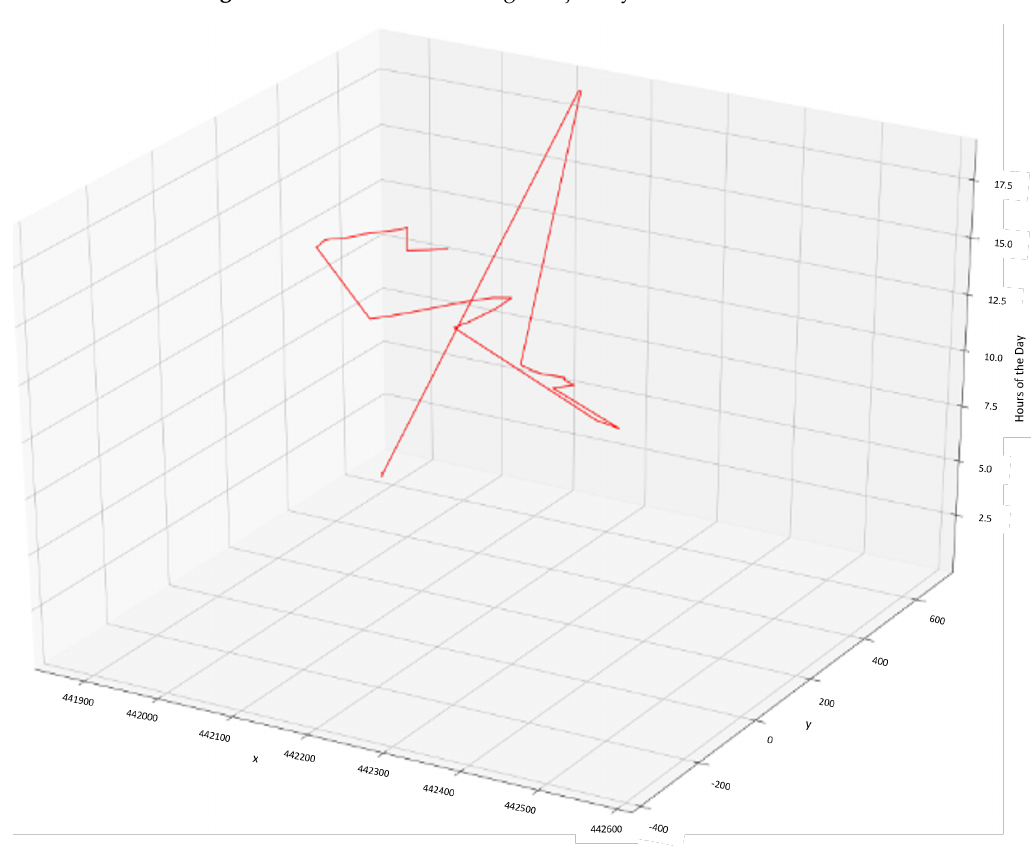
Figure 11. 4th Cluster with single